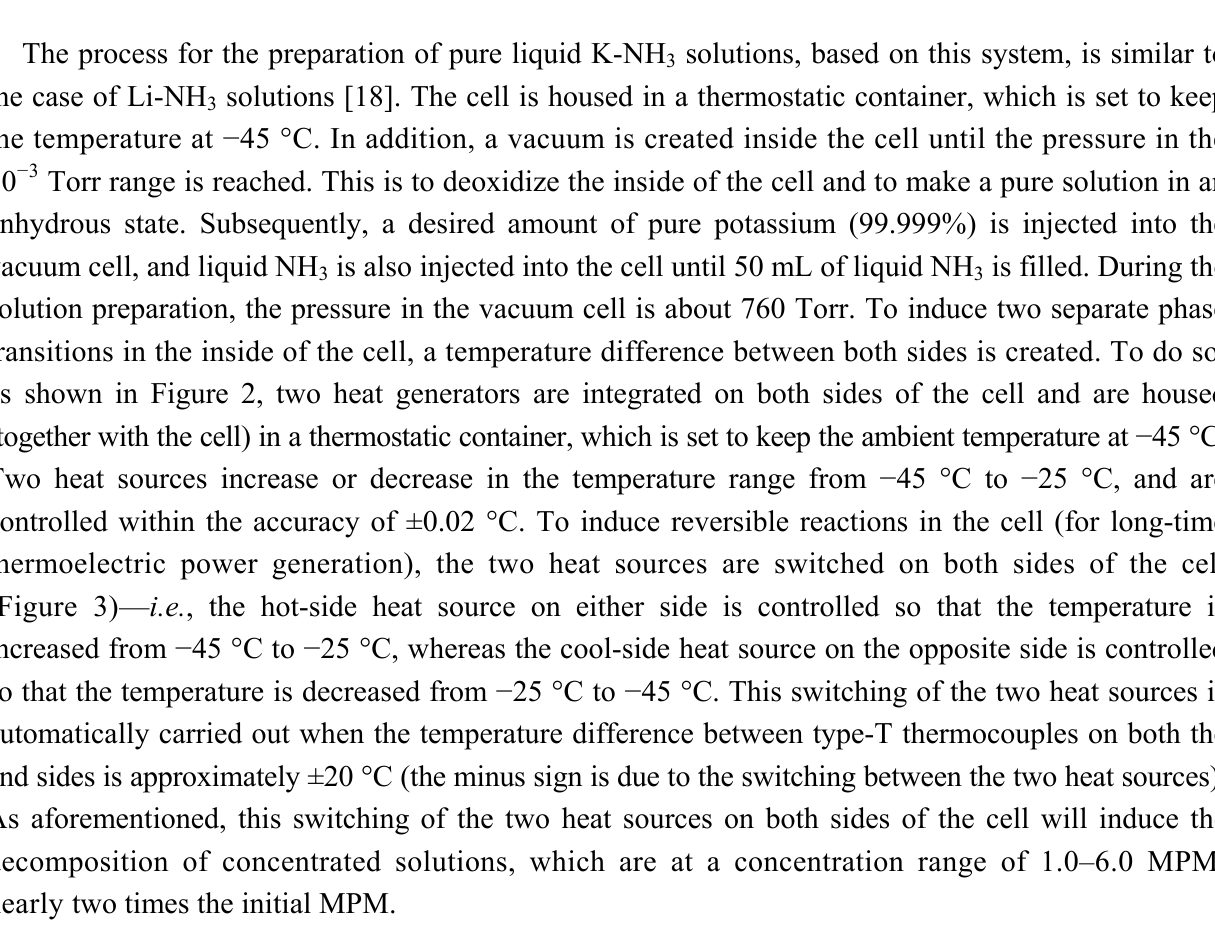
Figure 3. Control of the two heat sources on both sides of the cell: high and low temperatures induce “a phase transition to the dilute density” and “a phase transition to the concentrated density” in both sides of the cell,